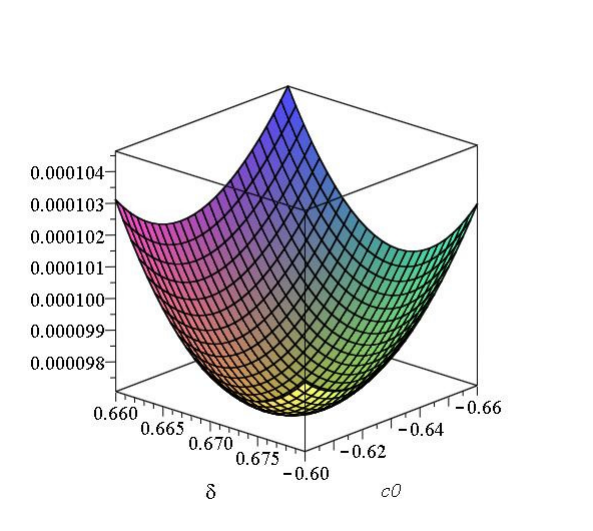
Fig. 2 Plot of E ( c 0 , δ ) , the squared residual error over η ∈ [ 0 , 499 ] as a function of c 0 and δ using parameter values Le = 2, Nb = 2, Pr = 1, Nt = 1, n = 0 . 5, A = 0 . 1314. The error function has minimum E ( c 0 , δ , A ) = 9 . 71 × 10 − 5 where c 0 = − 0 . 6195 and δ = 0 .